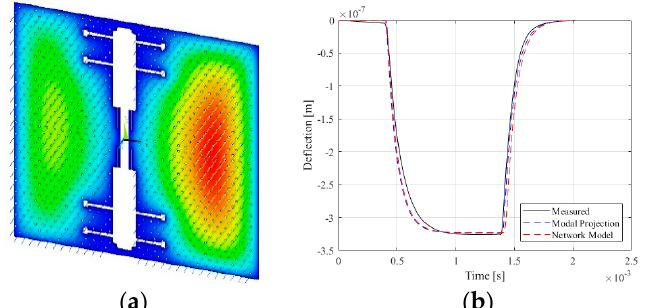
Figure 3. Analysis of a MEMS out-of-plane accelerometer. ( a ) Simulated pressure distribution over the plate region of an accelerometer. ( b ) Response to an applied voltage